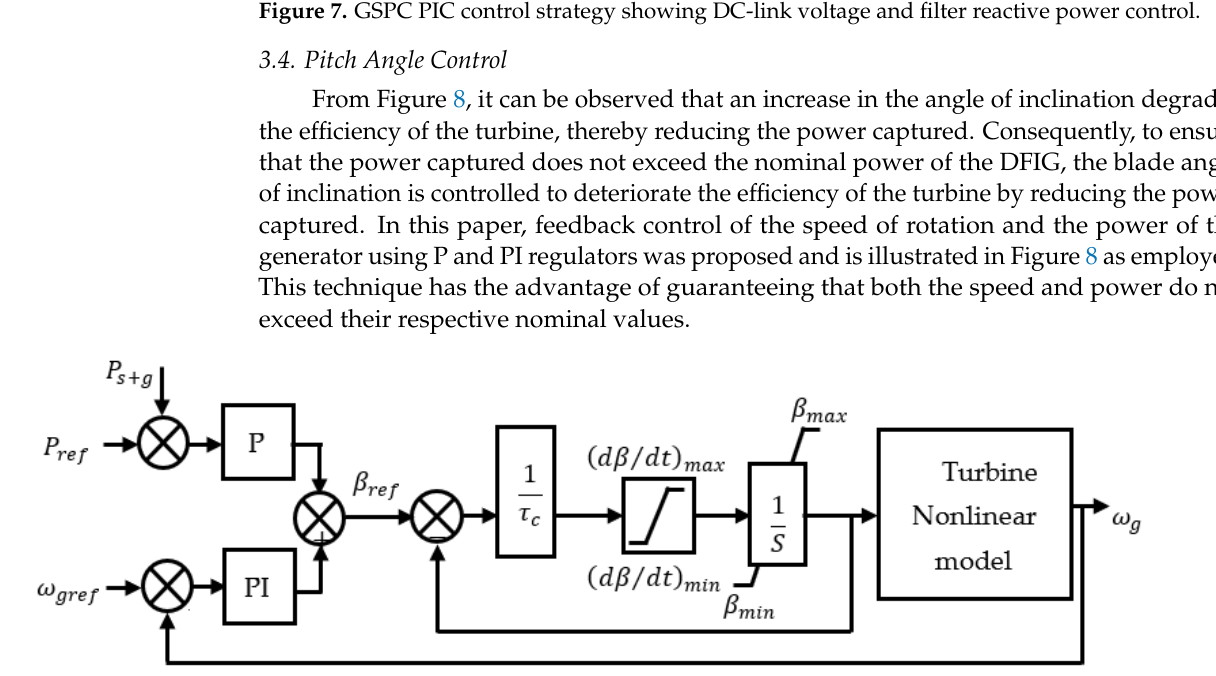
Figure 7. GSPC PIC control strategy showing DC-link voltage and filter reactive power control.